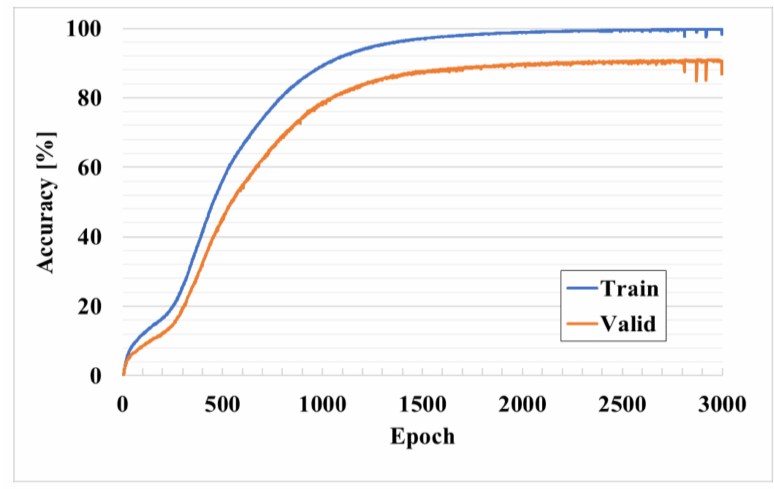
Figure 7. Accuracy results of training and verification data with respect to epoch.